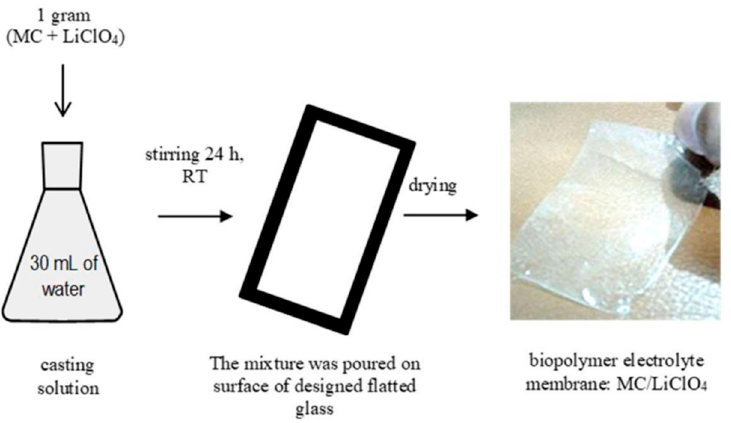
Figure 3. Synthesis of methyl cellulose/lithium perchlorate biopolymer electrolyte membrane [107]. Reproduced with permission (Copyright 2020 ITB Journal Publisher under CC BY